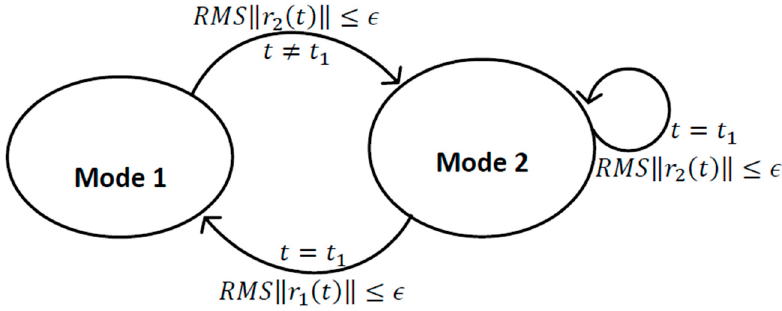
Figure 3. Graphical representation for switching between two modes.